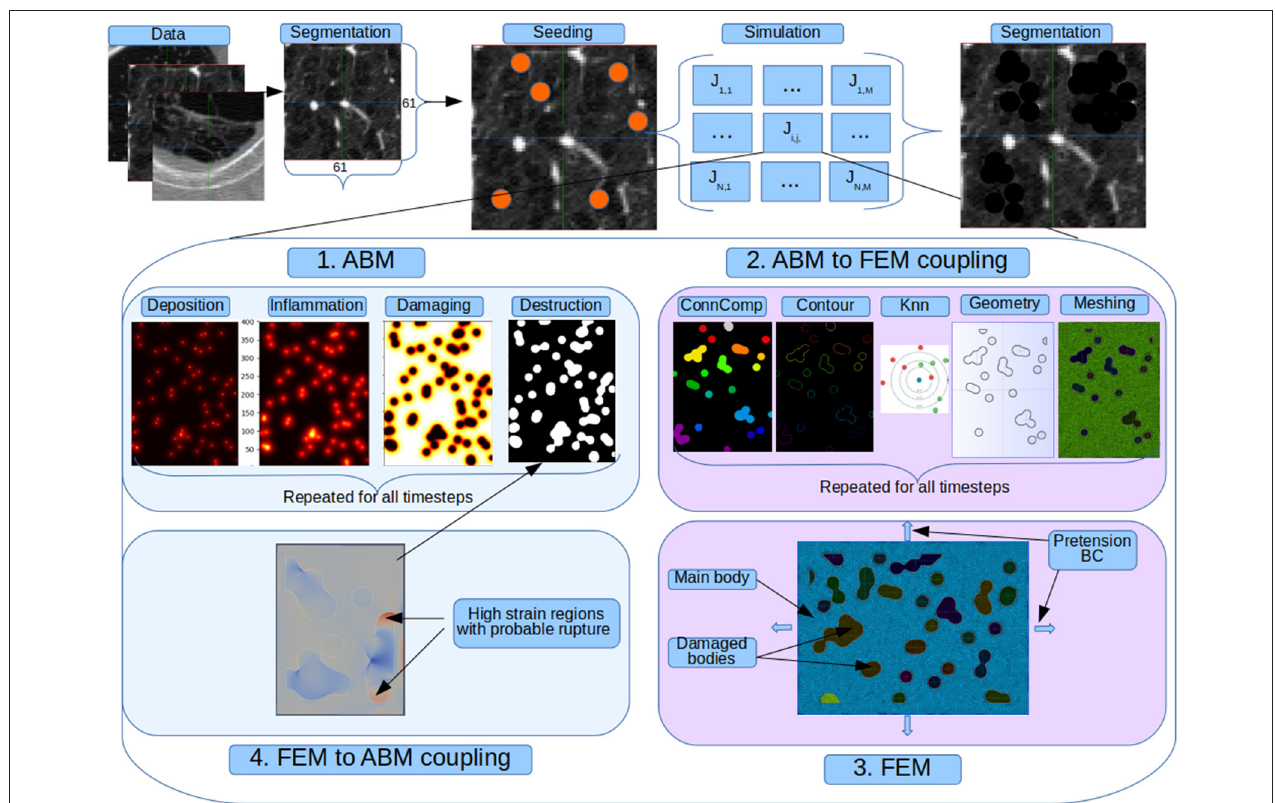
FIGURE 2 | Full coupled model. Original patches from a public emphysema database are segmented to separate the parenchyma from the vessels and airways and seed deposition is simulated. For each seeded pixel and for all its neighbors we run a simulation job that represent the evolution of 130 alveoli. In each job there is a cyclic sequence between the agent and finite element model. At each step the former simulate additional particle deposition that accounts for continued smoking; release of inflammatory cytokines and degradation of mechanical properties. Periodically the AB model is frozen and the calculated tissue properties are imported in the AB-FE coupler code which will reconstruct a topologically equivalent geometry, recover the contours of the damaged zones and assign new material properties taking into account the final amount of collagen and elastin from the AB model. The resulting information is passed to the FE solver that runs until convergence and then export the strain results for further processing. After the FE solver has run, the second coupler code, FE-AB is run to import the strain field and calculate which fibers, if any, have been destroyed in the simulation. It thus updates the AB status and restarts it with the updated state.